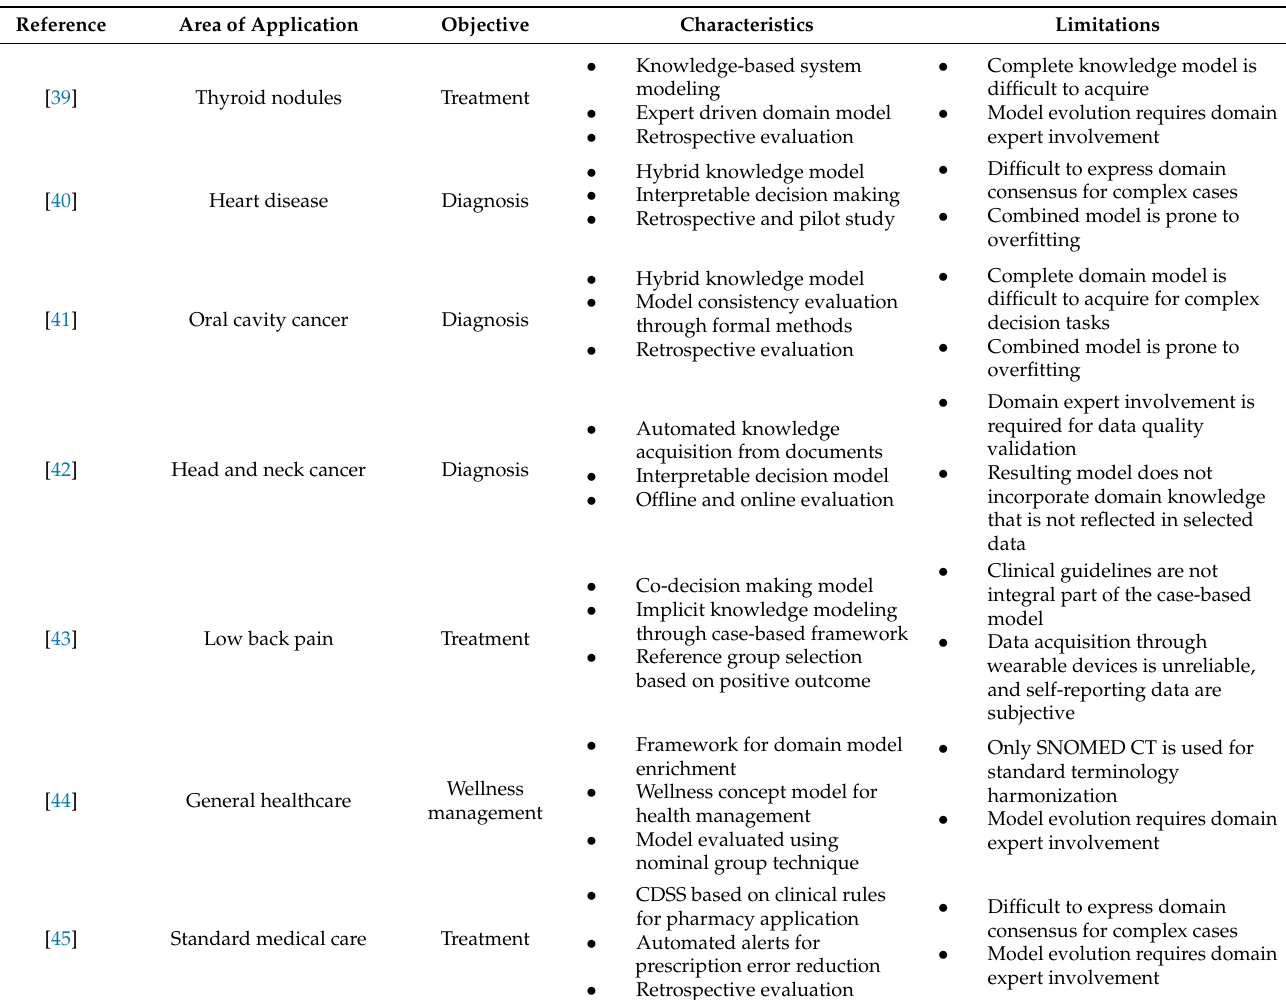
Table 2. Literature Comparison–Knowledge